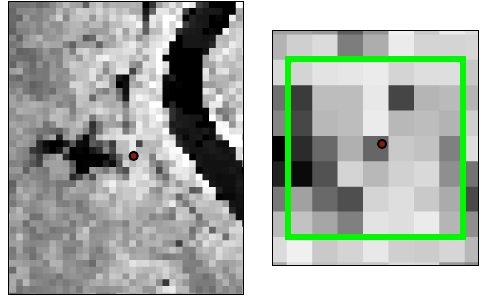
Figure 3 . CHM pixels for a site adjacent a wetland, with variation of heights shown in the image tensor window.